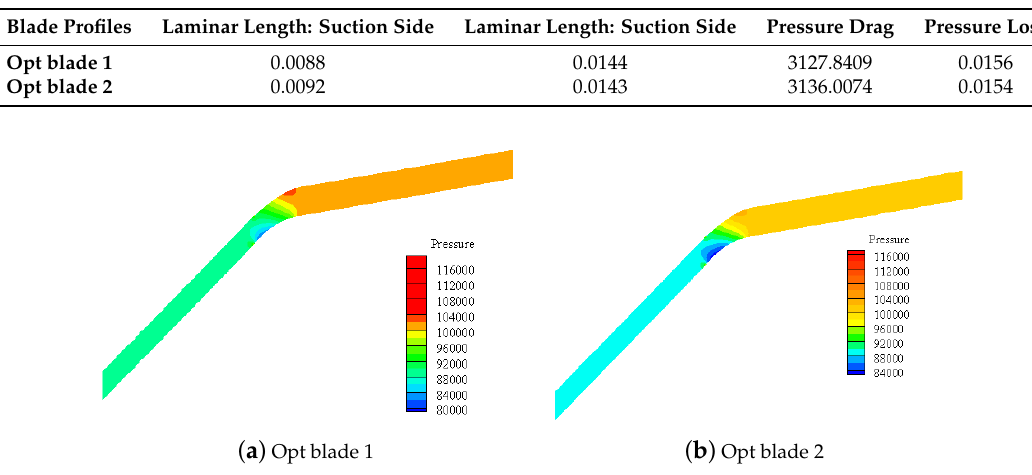
Figure 17. The skin friction drag coefficient and pressure distribution comparison of the two optimized blade profiles with different design objective formulations. Table 6. Optimization results comparison of the two optimized blades.